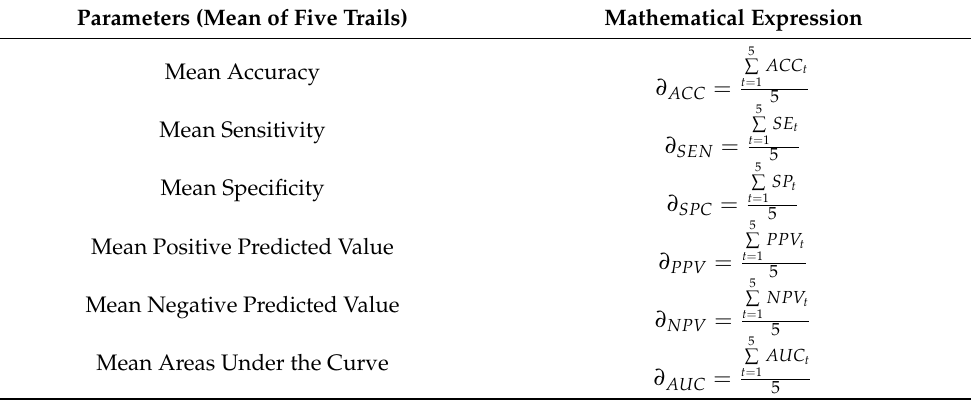
Table 5. The mathematical expression of mean test performance of five trials of an experiment. Parameters (Mean of Five